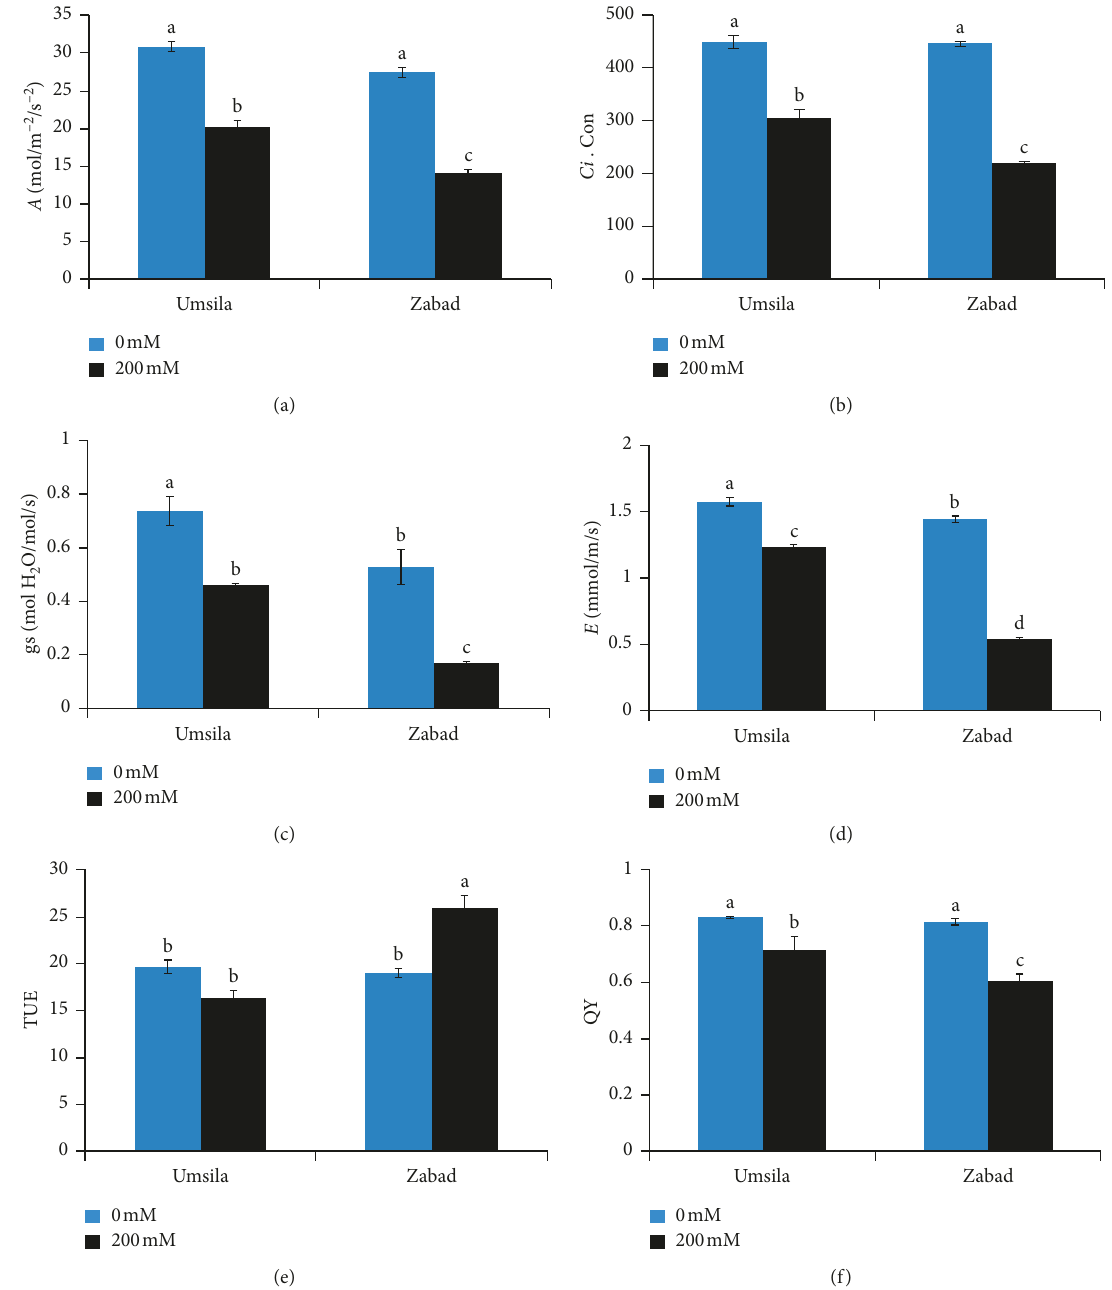
Figure 3: Effect of salinity on photosynthesis rate ( A ) (a), intercellular CO 2 concentration ( Ci ) (b), stomatal conductance (gs) (c), transpiration use efficiency (TUE) (d), water use efficiency ( WUE ) (e), and quantum yield (Qy) (f) in Umsila and Zabad date palm cultivars exposed to control and salinity. Bars represent means ± SE ( n � 3). Bars with the same letter are not significantly different at the p ≤ 0 . 05